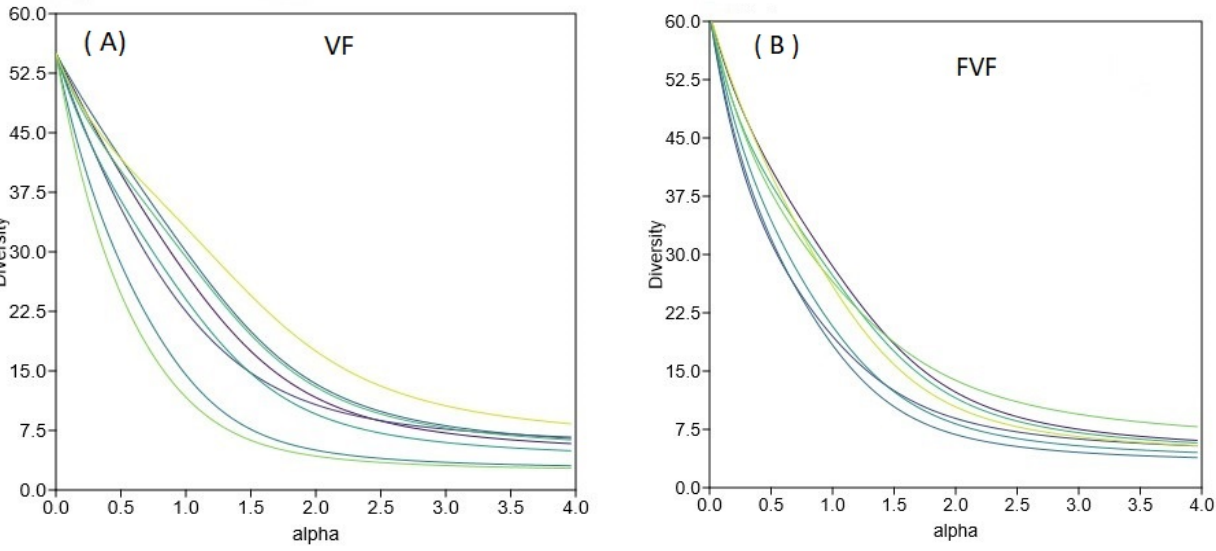
Figure 6. Diversity profiles of both forest types using the exponential of the Renyi diversity index. (( A )—virgin forest (VF), ( B )—former virgin forest (FVF)). The scale alpha values: alpha = 0—provides the total number of species, alpha = 1—gives a measure directly proportional to the Shannon index, alpha = 2—similar to Simpson’s index, high alpha value estimate the Berger–Parker index. Different color of lines represents the sampled plots within each forest type.